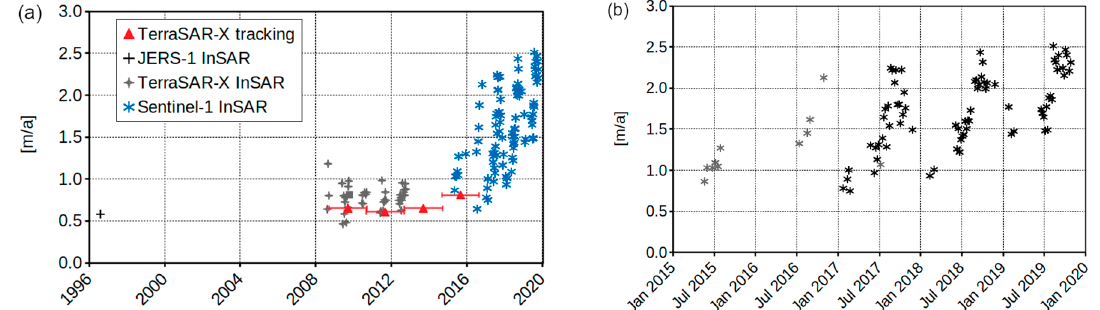
Figure 2. ( a ) Distelhorn rock glacier (Mattertal, Switzerland) with position of the time series of Figure 3 (black dot), image data are from Google, DigitalGlobe; ( b ) Sentinel-1 interferogram from 12.08.2016 to 24.08.2016, 2 π ⇔ 2.8 cm; ( c ) Sentinel-1 interferogram from 02.08.2018 to 08.08.2018, 2 π ⇔ 2.8 cm; ( d ) Sentinel-1 line-of-sight displacement in cm from 02.08.2018 to 08.08.2018; ( e ) JERS-1 interferogram from 21.06.1996 to 17.09.1996, 2 π ⇔ 11.8 cm; ( f ) TerraSAR-X interferogram from 04.09.2012 to 15.09.2012, 2 π ⇔ 1.6 cm; ( g ) Displacement in m along the terrain surface from TerraSAR-X offset tracking from 15.09.2012 to 22.09.2014. The black arrow indicates the satellite line-of-sight.